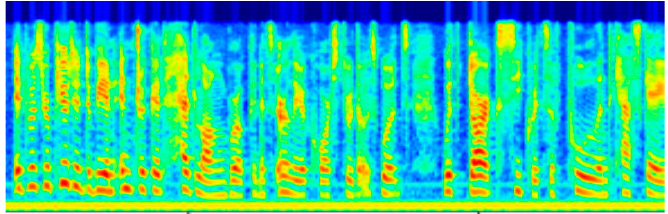
Figure 1. Mel Spectrogram. of filters in the human auditory system. It is specified on the Equivalent Rectangular Bandwidth (ERB) scale, which is a psychoacoustic measure of the width of the auditory filters. Representing low frequency speech in higher resolution [24], non-linear rectifica- tion [7] and measuring of psychoacoustics feature from the speech make Gammatone filter banks more preferable speaker characterization in noisy condition. GFTB is computed from the FFT, then stacked together to form Cochleogram. Sample Cochleogram is shown in Figure 2 below.